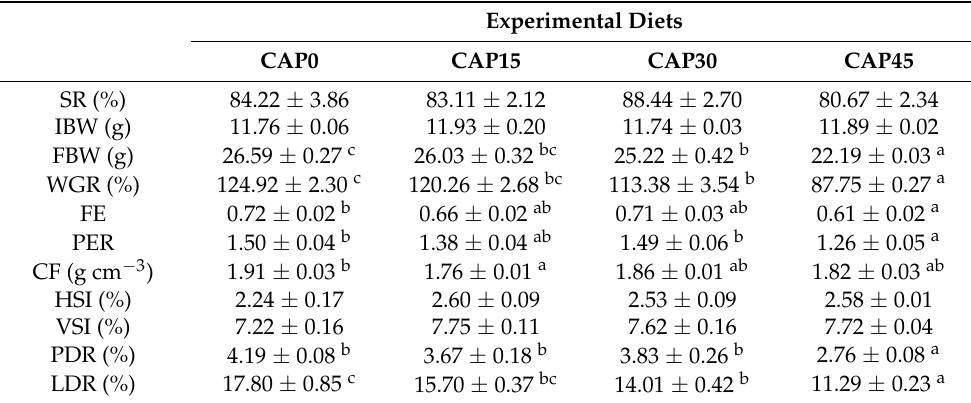
Table 3. Growth, feed utilization, morphological parameters and nutrient depositions of large yellow croakers fed diets with different levels of CAP for 56